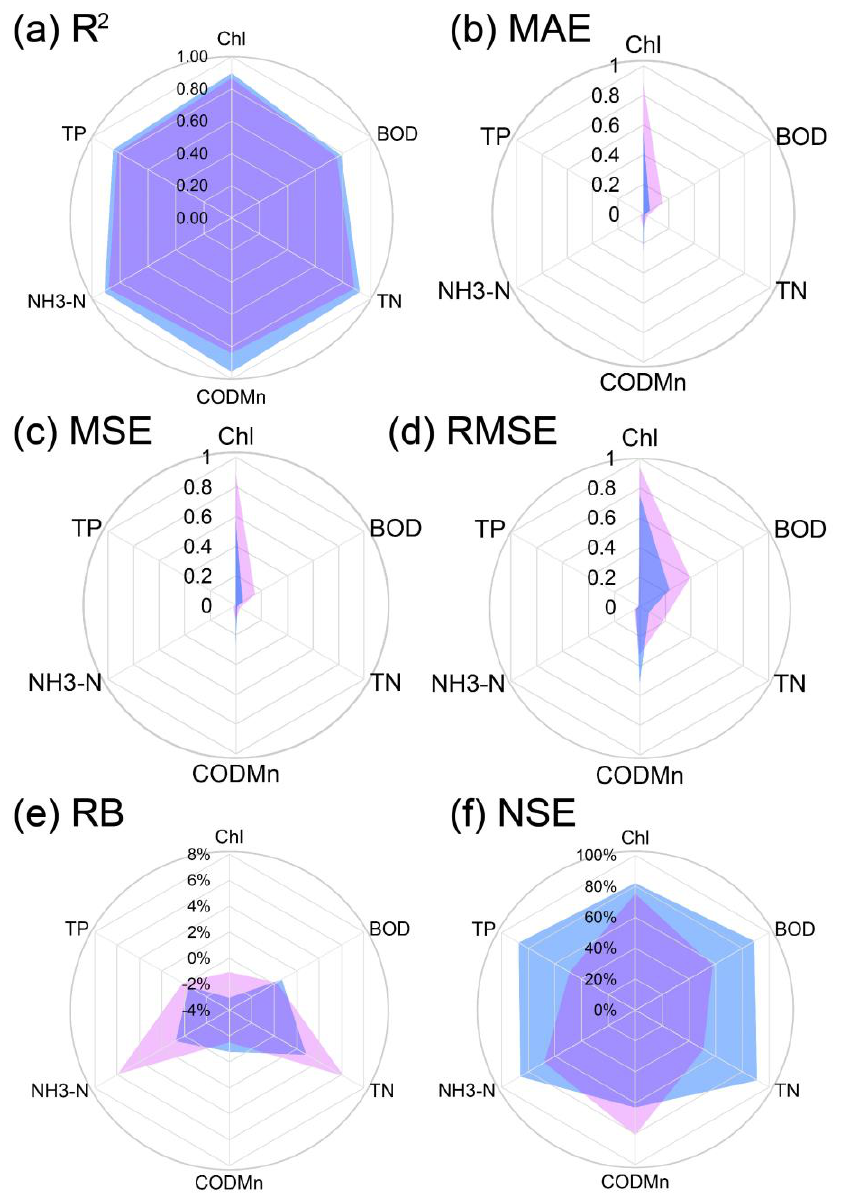
Figure 3. Results of the regression modeling between OLI-derived spectral properties and the corresponding water quality data from national monitoring sections: ( a ) R 2 , ( b ) MAE, ( c ) MSE, ( d ) RMSE, ( e ) RB and ( f ) NSE. The blue represents the results from the training period, while the pink represents the results from the testing period.